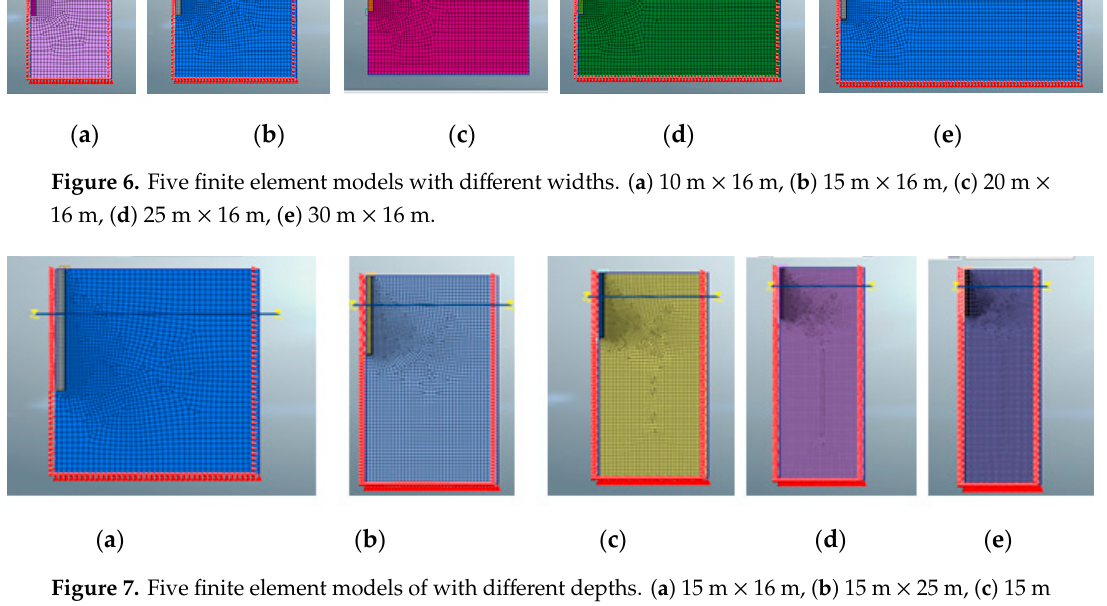
Figure 8. Relations between maximum obtained pile settlement and model geometry. ( a ) Model geometry width. ( b ) Model geometry depth. Based on the sensitivity analyses performed, it can be concluded that to achieve the maximum expected settlement, the numerical model should be established with high order medium to fine mesh and geometry dimensions of 20 m × 40 m to ensure that boundaries positions will not affect the results at the analysis zone. In addition, the pile should be represented by a fine mesh with a size of 0.216 m, and at least three mesh elements have to be adopted at its base.